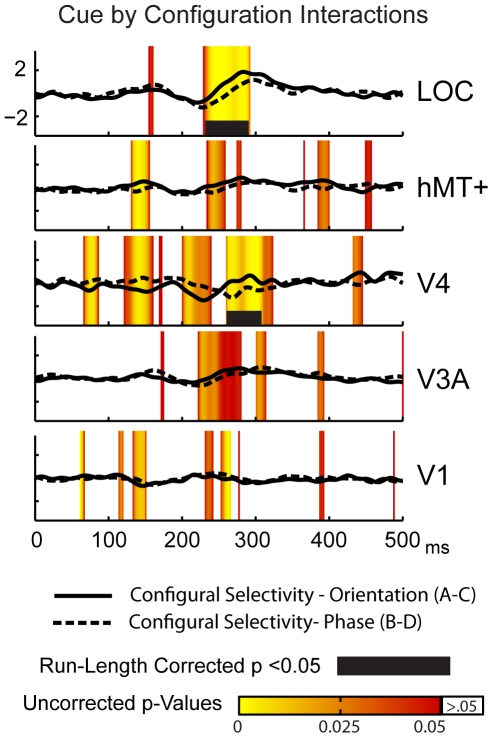
Source-space cue-configuration double difference.Differences between orientation- and phase-defined tsVEPs are restricted to longer latencies (>230 ms) and higher cortical areas (V4 and LOC).